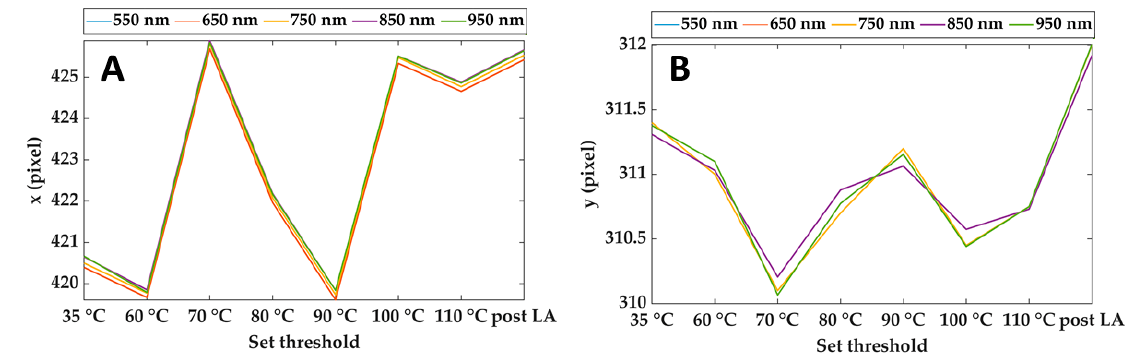
Figure 4. Horizontal ( A ) and vertical ( B ) coordinates of the reference point (center of the cropping rectangle) for different wavelengths and during the treatment. Results refer to Test 1.